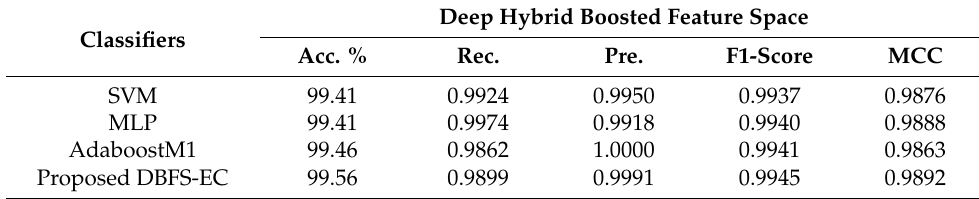
Table 6. Deep boosted feature space and ensemble classification (DBFS-EC) 60:40% data portioning (training: